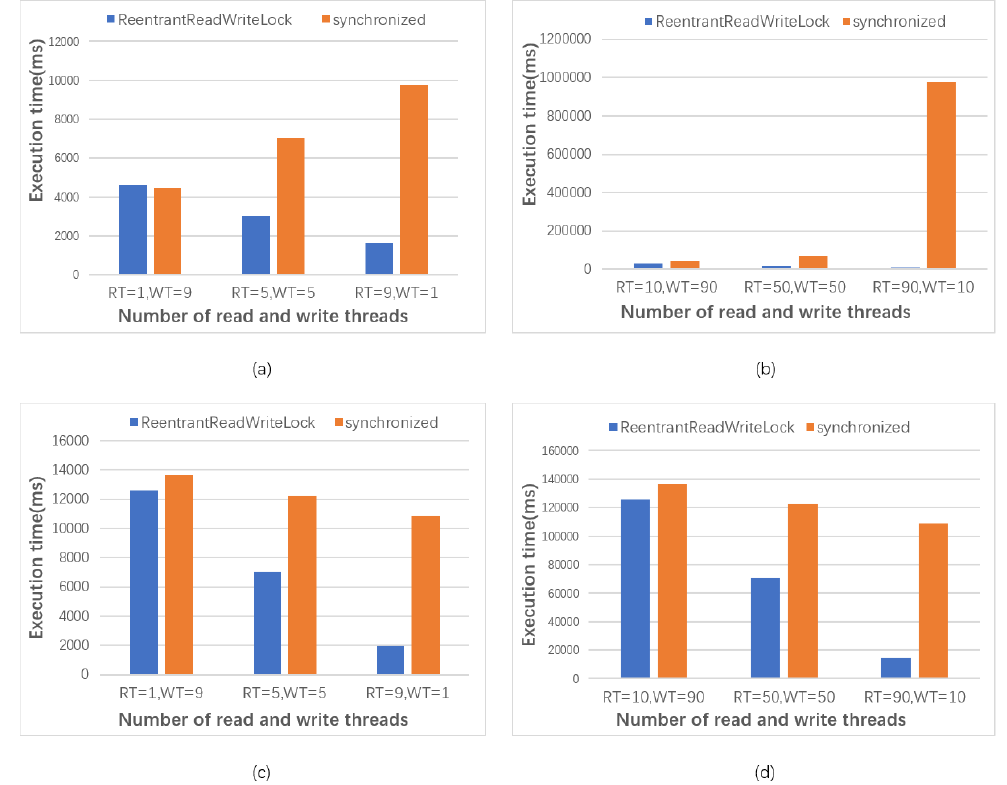
Figure 2. Performance results. ( a ) Results of synchronized lock and ReentrantReadWriteLock with 10 threads; ( b ) Results of synchronized lock and ReentrantReadWriteLock with 100 threads; ( c ) Results of synchronized lock and lock downgrading with 10 threads; ( d ) Results of synchronized lock and lock downgrading with 100